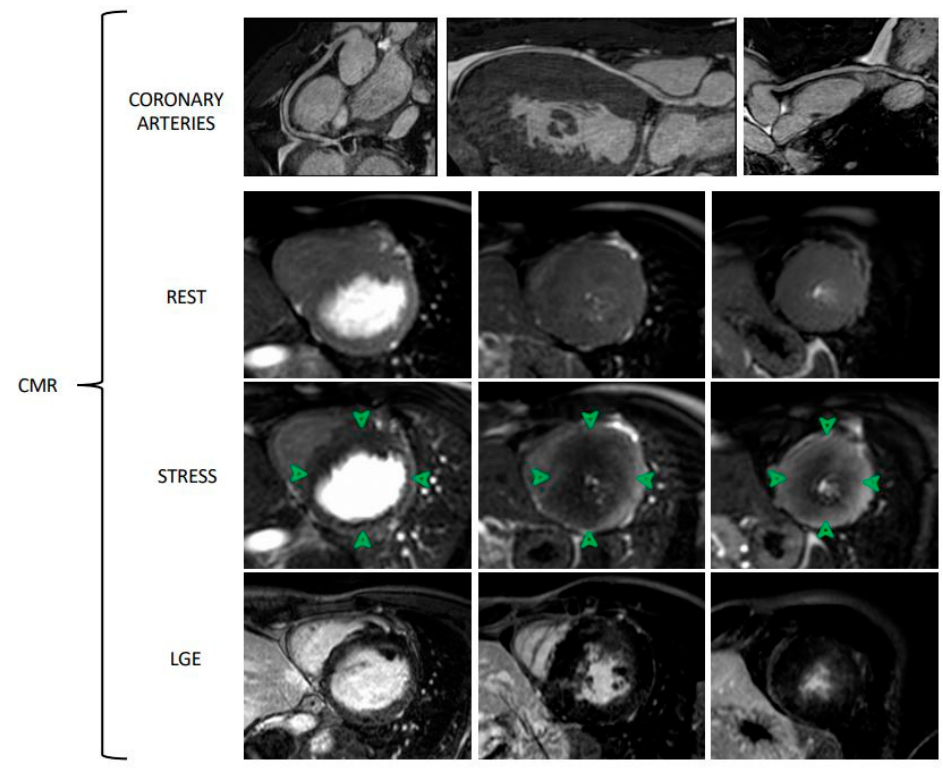
Figure 4. CMR assessment of microvascular dysfunction in a young patient with Danon disease. CMR analysis includes sequences for the visualization of epicardial coronary arteries, rest and stress protocols and LGE images of three ventricular slices (basal, mid-ventricular, apical slices). Stress CMR is performed by adenosine administration (140 mcg/Kg/min for 3–6 min). Comparing rest and stress images, a diffuse subendocardial hypoperfusion (green arrows) due to microvascular dysfunction can be noted. LGE images show no ischemic pattern. CMR Sequences: Free-breathing diaphragmatic 3D navigator BFTE Whole heart non contrast sequences for coronary arteries images, Saturation recovery gradient echo pulse sequences for rest and stress images, and Inversion recovery gradient echo sequences for LGE images.